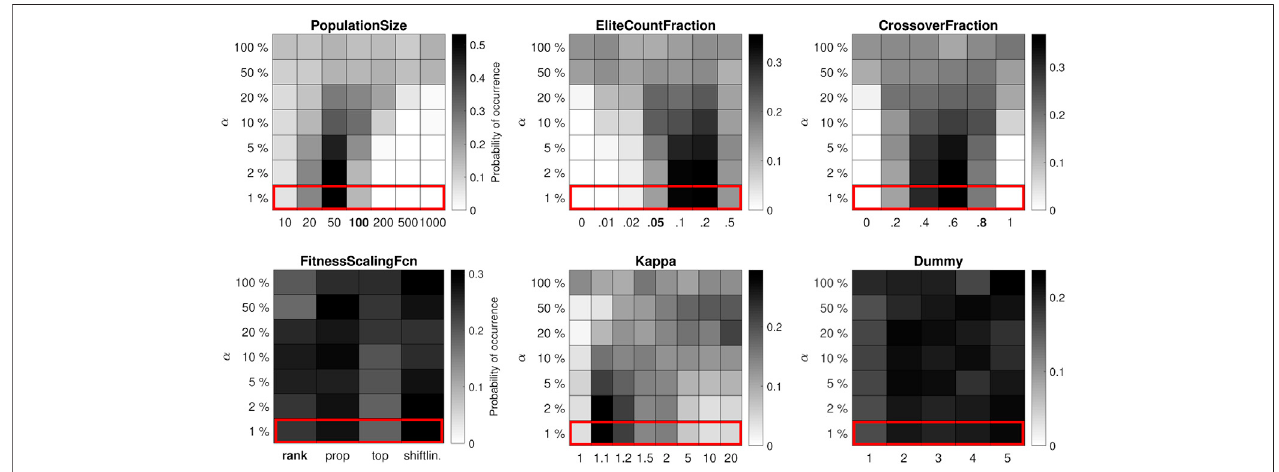
FIGURE 1 | Distribution of control parameter values for the 10-bar truss test problem, where each run of the algorithm has a relatively low budget of 10 4 function evaluations. The performance of the GA is signi fi cantly affected by the control parameter